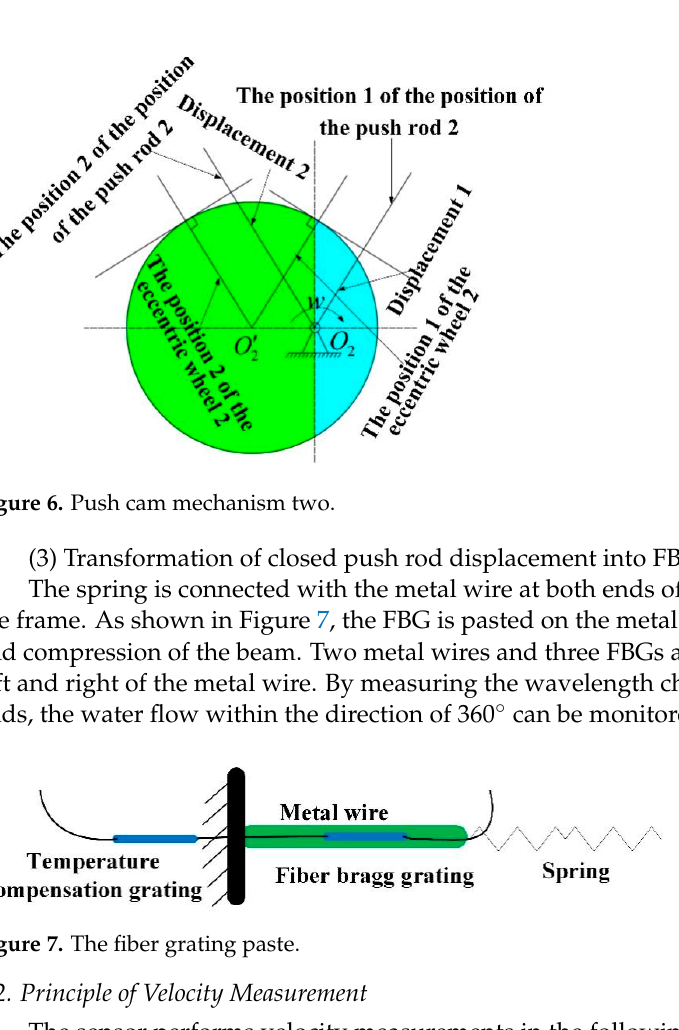
Figure 7. The fiber grating paste.